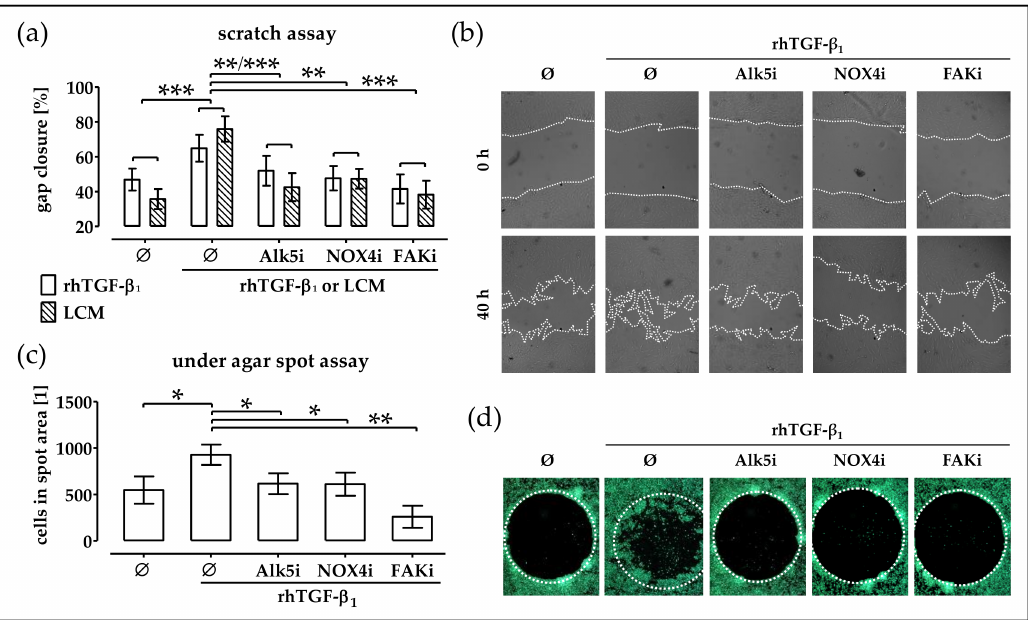
Figure 6. rhTGF- β 1 induces migration of phOBs via NOX4 -dependent activation of focal adhesion kinase. The phOBs migration was investigated by scratch assay and under agar spot assay. phOBs ( N ≥ 4, n ≥ 4) were stimulated with 5 ng/mL rhTGF- β 1 or LCM (leucocyte conditioned medium) and the respective inhibitors for Alk5i (5 nM SB431542), NOX4i (50 µ M Apocynin), and FAKi (5 µ M FAKi14). ( a ) For the scratch assay, the gap closure was determined from microscopic images (100 − gap area 40h /gap area 0h × 100) with the help of the ImageJ software. ( b ) Representative microscopic images for the scratch assay (20 × magnification). ( c ) For the under agar spot assay, the number of cells in the spot area was determined from microscopic images with the help of the ImageJ software. ( d ) Representative microscopic images for the under agar spot assay (12.5 × magnification). Cells were visualized with Calcein-AM stain for living cells. Data are represented in bar diagrams (mean ± 95% C.I.). * p < 0.05, ** p < 0.01, and *** p < 0.001 as